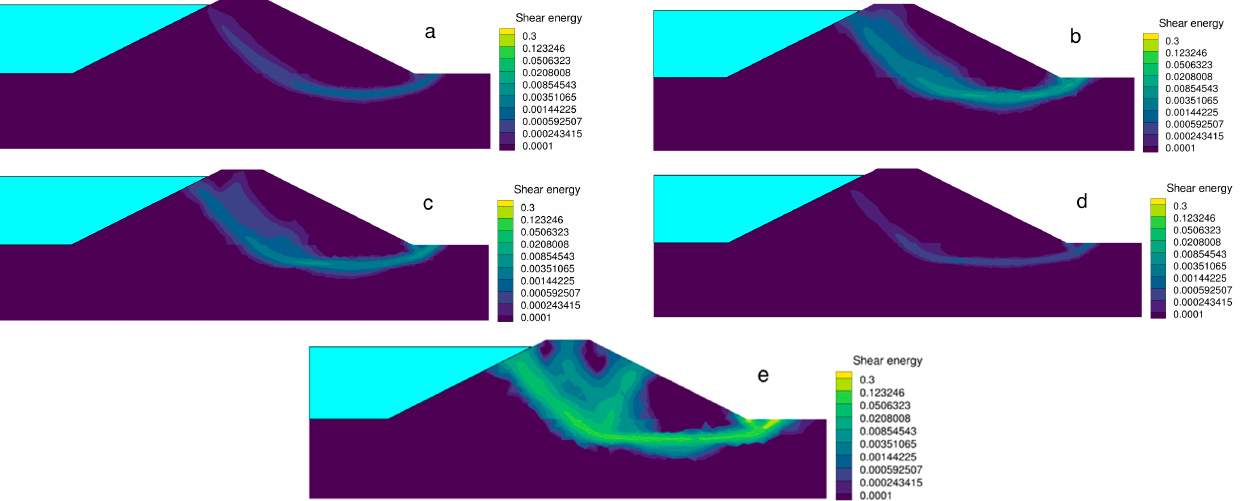
Figure 12. The contours of shear dissipation energy based on l x = 50 m, WL = 5 m: ( a ) COV = 0.1; ( b ) COV = 0.2; ( c ) COV = 0.3; ( d ) COV = 0.4; ( e ) COV = 0.5.